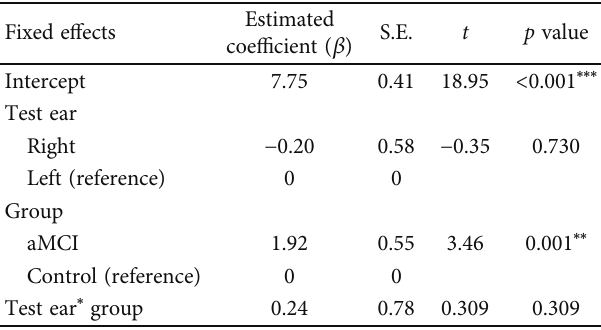
Table 4: Estimated fi xed e ff ects of predictors for approximate threshold of gap